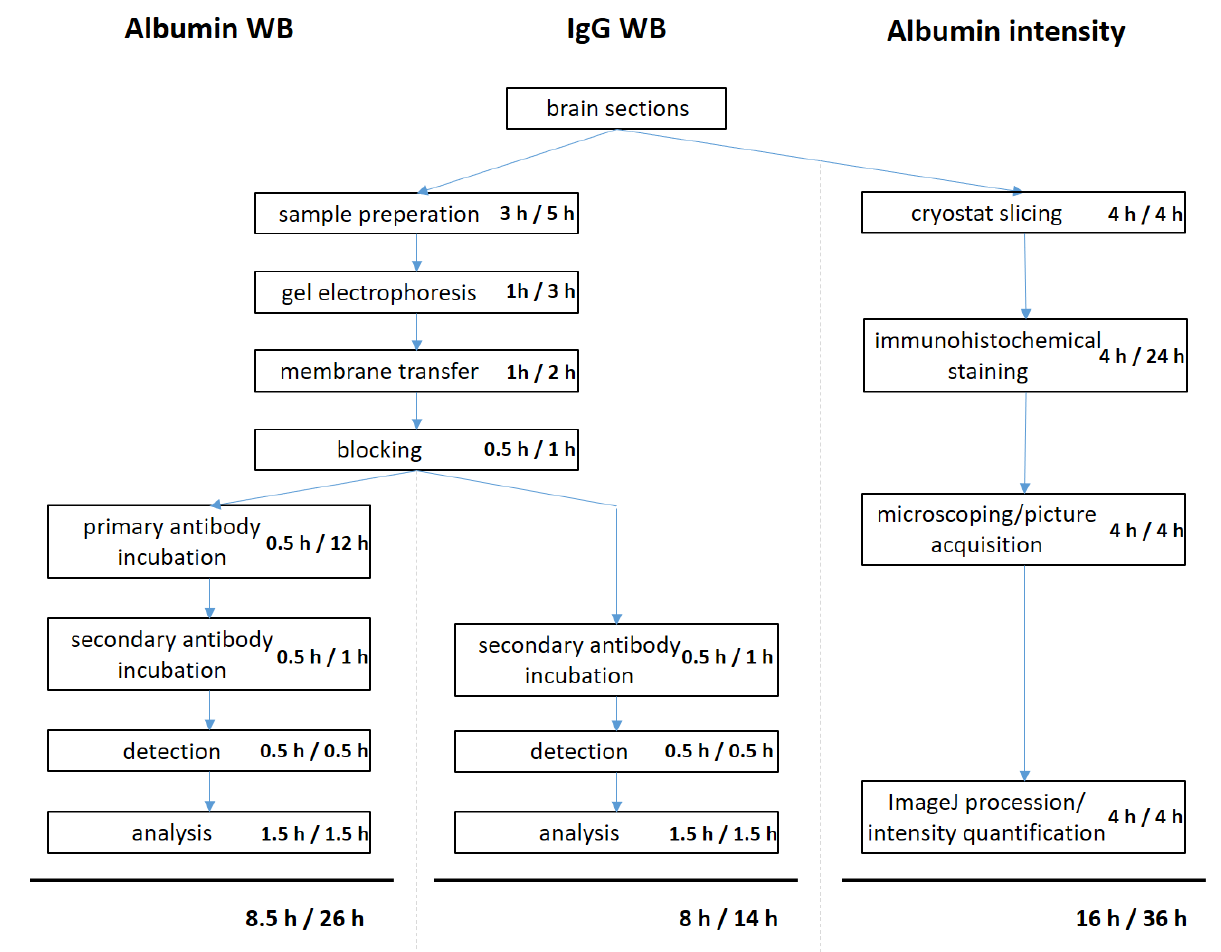
Figure 2. The IgG WB is the less time-consuming method in comparison to albumin Western Blot and AIM. The time investment for the single steps of the three different methods to evaluate BBB disruption was identified for a group size of eight mice. The first listed time period depicts the hands-on time, during which the scientist is tied to the respective procedure. The second time period comprises the active steps of the procedure as well as the preparation and post processing steps, if needed.